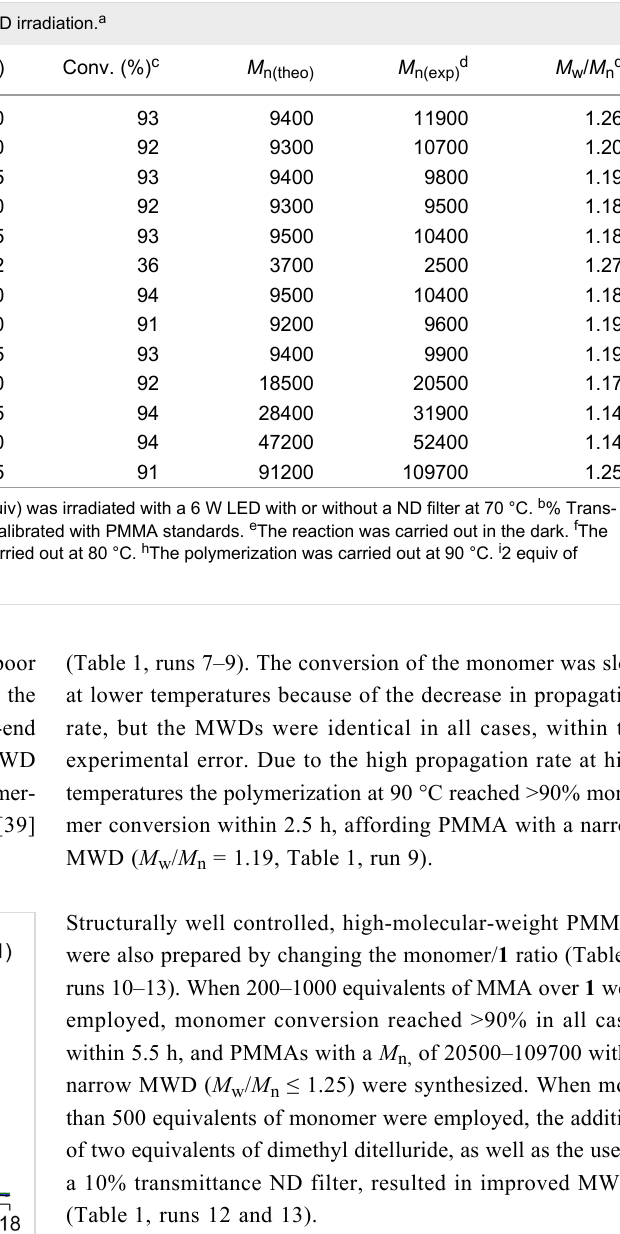
(Table 2). For example, TERP of methyl acrylate (100 equiv) without ditelluride reached 91% monomer conversion after